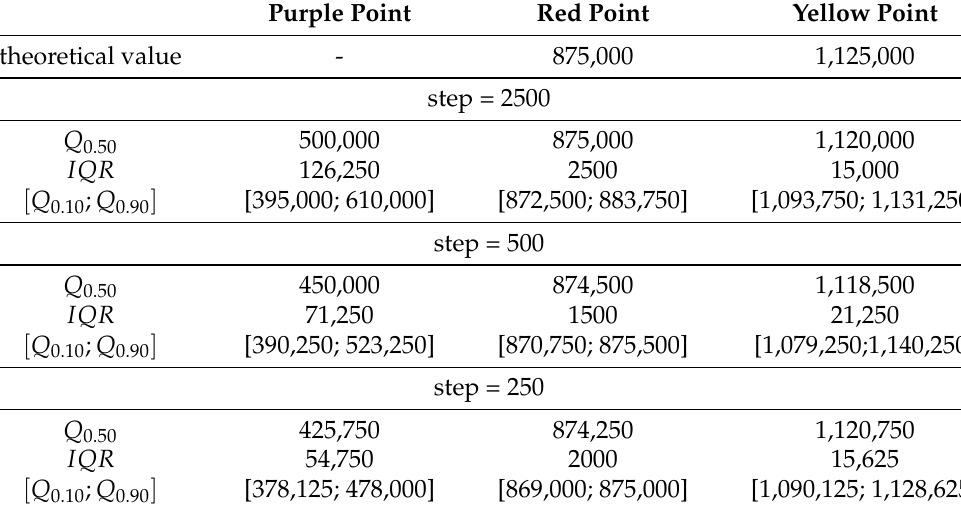
Table 2. Medians, intequartile ranges (IQR), and 80% quantile intervals calculated based on the identified moments of the first (purple), the second (red), and the third (yellow) regime changes for M = 100 simulated signals for the procedure applied to non-overlapping windows of length 2500 with step equal to 2500 and to the overlapping windows of length 2500 with step equal to 500 and